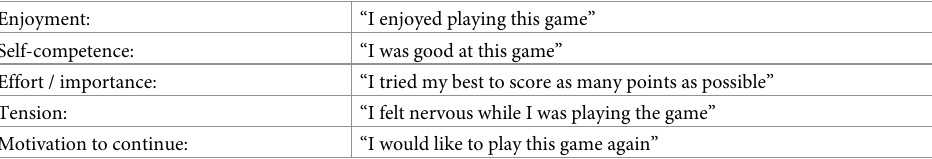
Table 1. The five items used in our modified Intrinsic Motivation Inventory